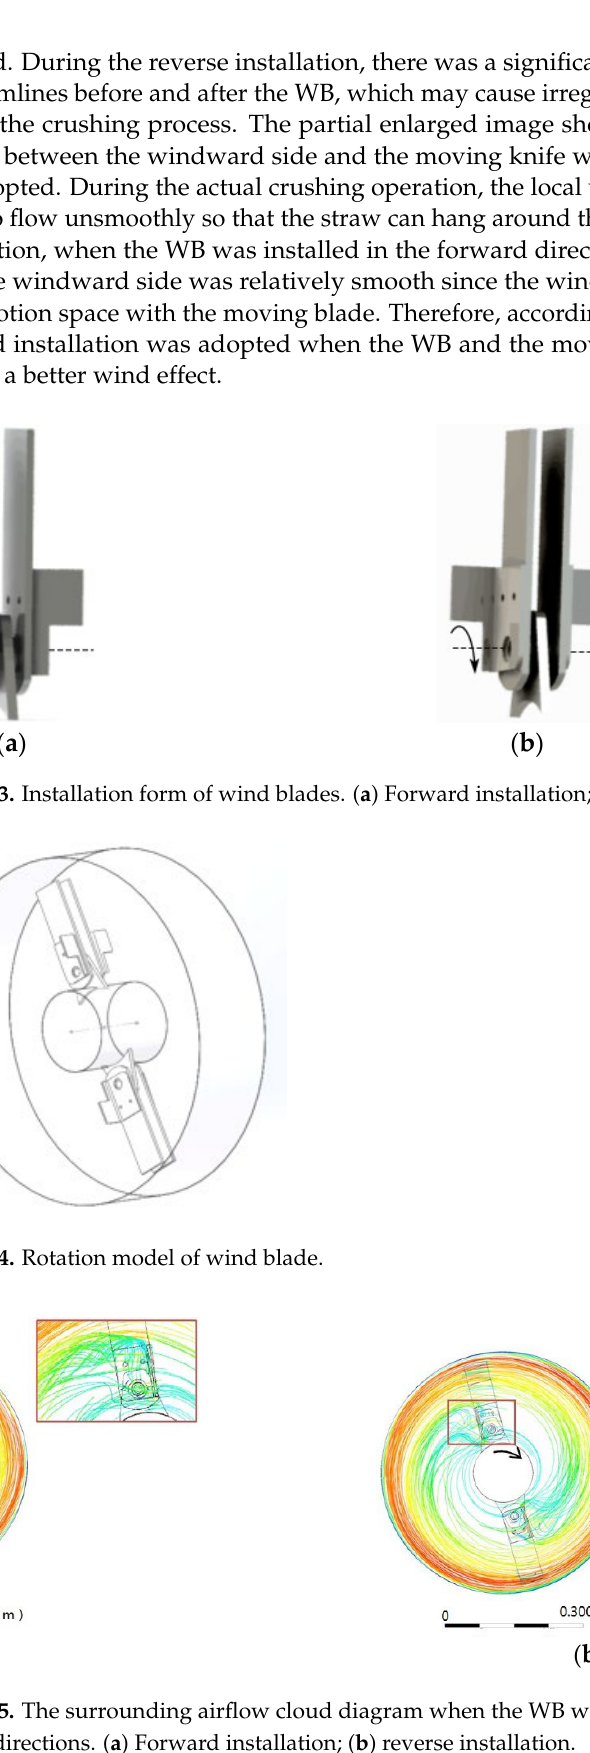
Figure 13. Installation form of wind blades. ( a ) Forward installation; ( b ) reverse installation.